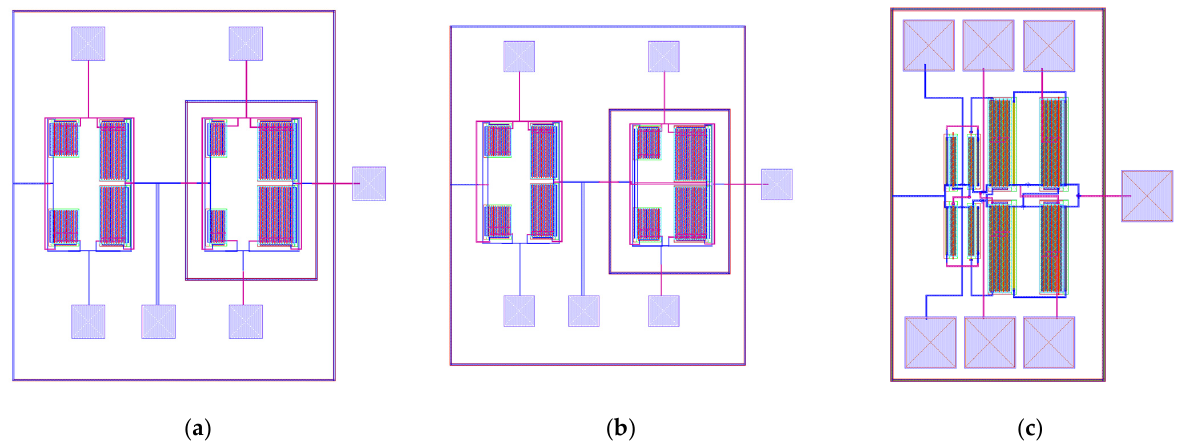
Figure 5. Layout of the topology CDC ( a ), CDB, ( b ) and CDN ( c ) in 32 nm with, the iPDK using Cdesigner. The capacitors are not represented because they are occupying much more space in the layout. In pratice, the large capacitors can be used in the metal layers.